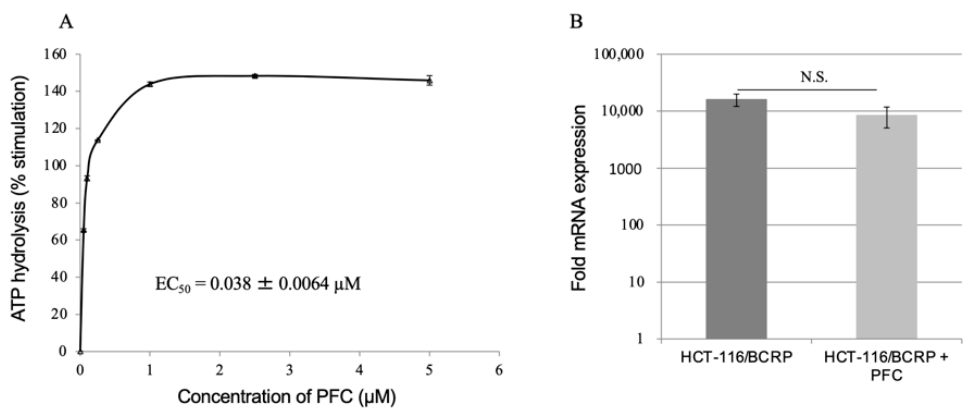
Figure 3. Effect of the phenylfurocoumarin derivative PFC on ATPase activity of ABCG2 and mRNA expression of ABCG2. ( A ) Representative data from four independent experiments. Each point represents a mean ( n = 4). The concentration of PFC required for 50% stimulation (EC50) is shown as mean ± SE. ( B ) ABCG2 mRNA expression in HCT-116/BCRP and HCT-116/BCRP with PFC was measured by qPCR, relative to that of HCT-116. Data are shown as mean ± standard error (SE) ( n = 3). N.S. not significant.